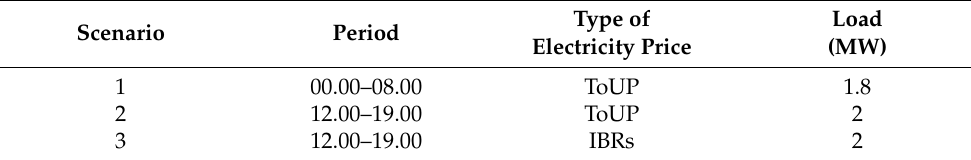
Table 3. The scenarios studied in the